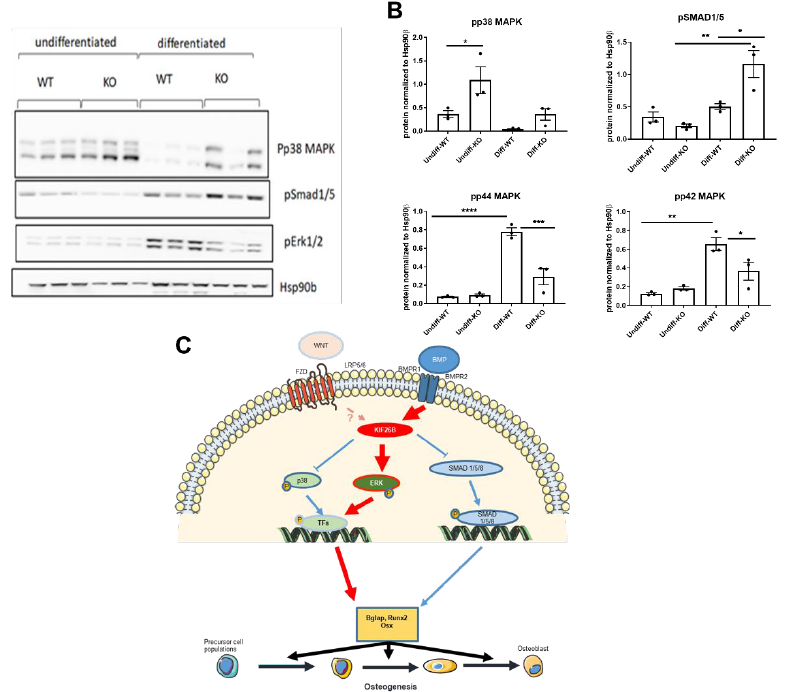
Figure 4. KIF26B-deficiency leads to dysregulated osteogenic signaling, impairing the activation of ERK MAPKs. ( A , B ) p38 MAPK, SMAD1/5 and ERK1/2 phosphorylation in WT and Kif26b CRISPR cells was assessed by Western blotting. Cells were differentiated for 8 days (WT/KO) (n = 3 biological replicates). ( B ) Western blot data were quantified using Image Studio Lite Ver 5.2. Analyses were one- way ANOVA with Tukey’s multiple comparison test. D ata are plotted as mean ± SEM. ( C ) Pro- posed model for the molecular mechanism of KIF26B and CASC20 in osteogenesis. Both KIF26B and CASC20 expression is induced by BMP2. Whilst the mechanistic contribution of CASC20 to HO is unclear, KIF26B appears to control the balance of signaling pathways that collectively regulate then expression of osteogenic genes. * p <0.05, ** p <0.01, *** p < 0.001, **** p < 0.0001.